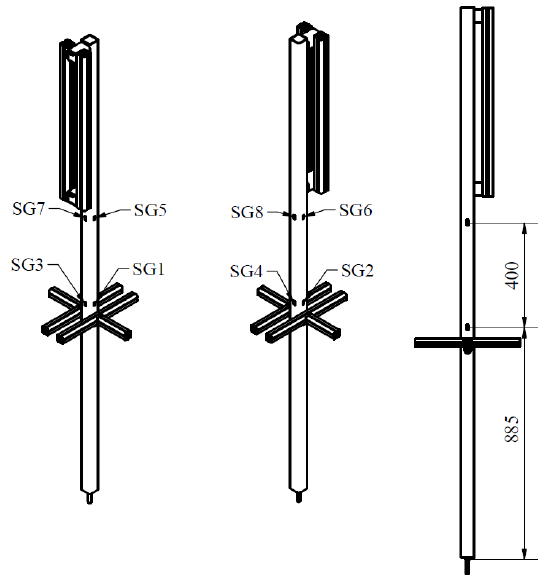
Figure 2. Location of strain gauges SG1...SG8 on the measurement beam (item 5 in Figure 1, dimensions in [mm]).